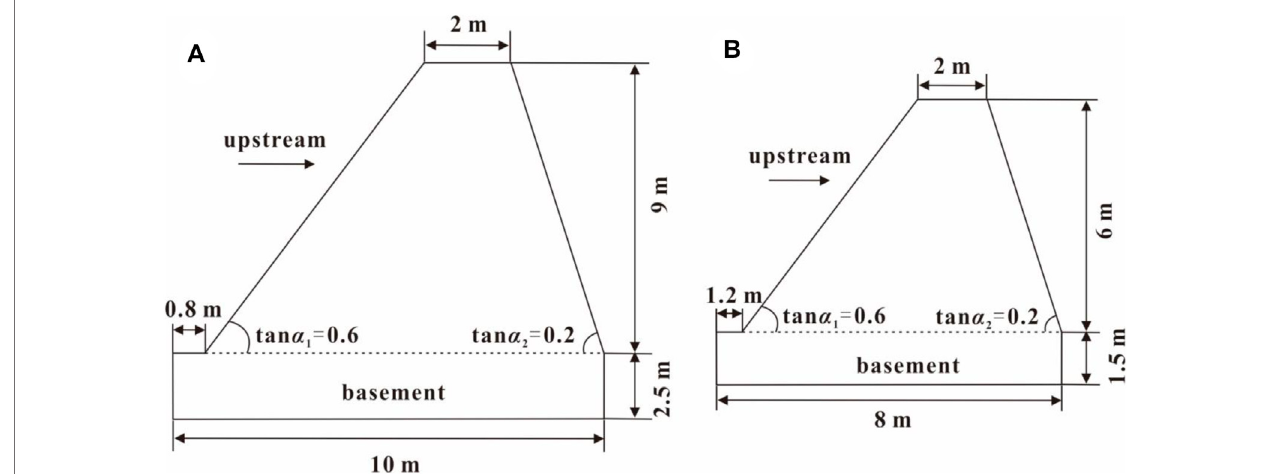
FIGURE8 | Design ofcross section ofthedams forblocking the debris fl ow: (A) dam 1#located in theupper stream and (B) dam 2# located in the middle stream.